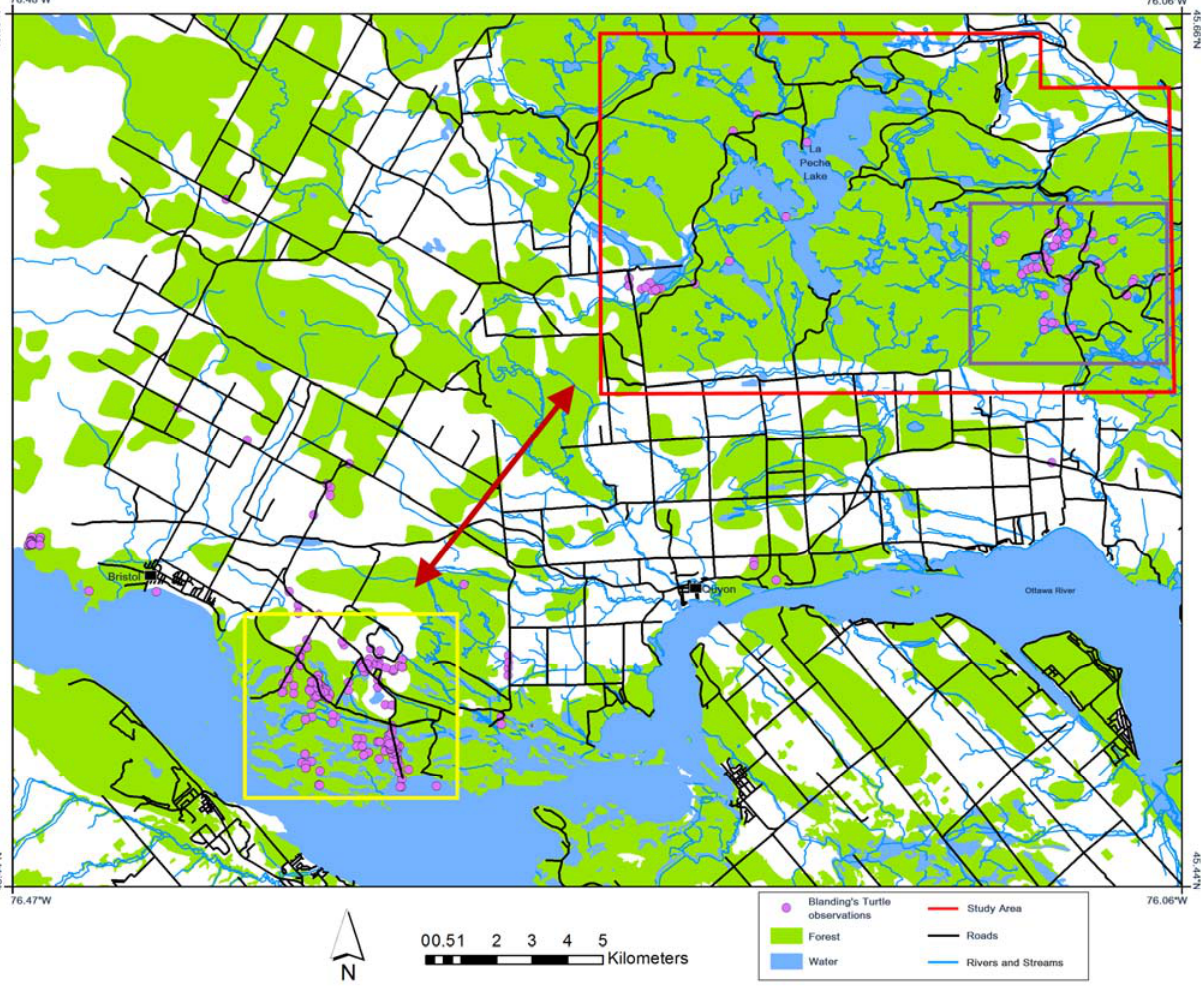
Figure 4. Study area (red outline) in relation to the other primary nearby population (yellow outline) and the hypothesized ecological corridor between them (red arrow). Adapted from [18,43–46]. The purple rectangle shows an area of clustered observations near a road and system of